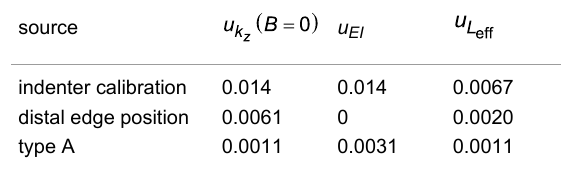
Table 3: Relative uncertainty contributions. Type A estimates corres- pond to the indentation data from the qPlus A